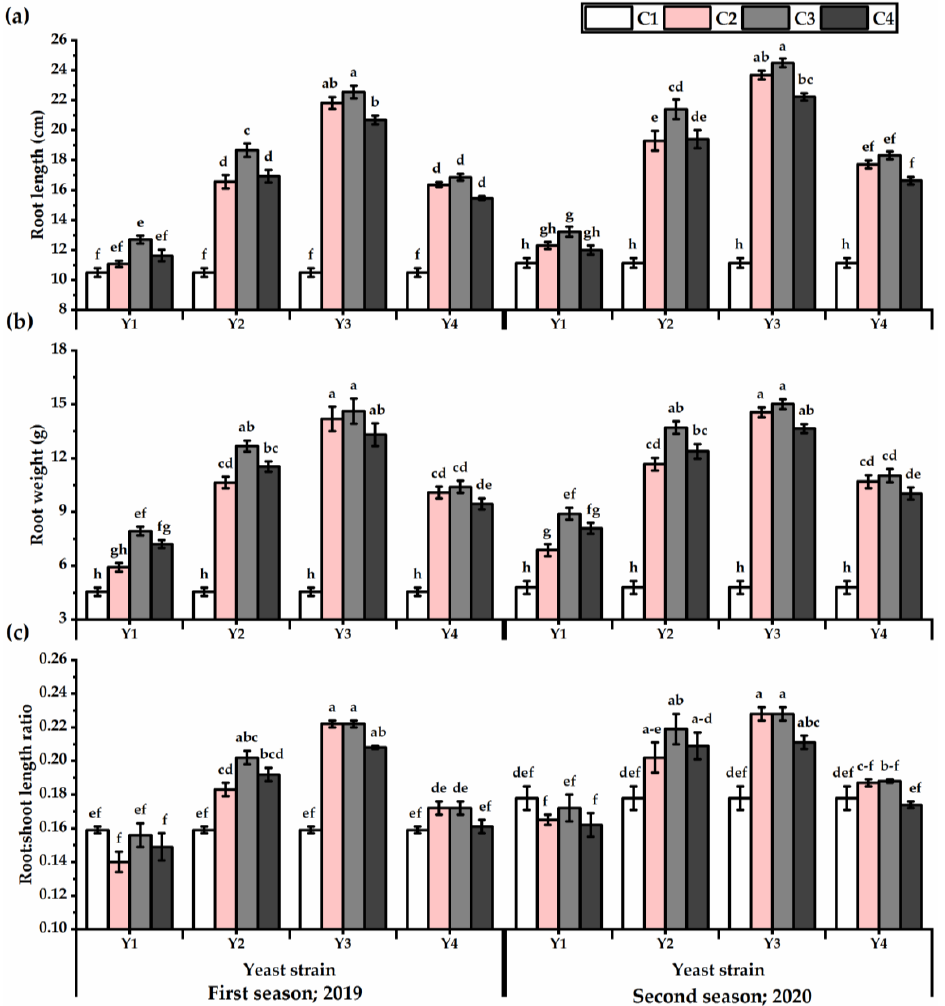
Figure 2. Root length (cm) ( a ), root weight (g) ( b ), and root:shoot length ratio ( c ) of Plectranthus amboinicus (Lour.) Spreng. plants subjected to Rhodotorula muciligenese (Y1), Candida sake (Y2), Candida apicola (Y3), and Candida kunwiensis (Y4) yeast strains foliar application at 0 (C1), 1 × 10 4 (C2), 1 × 10 7 (C3), and 1 × 10 9 (C4) CFU mL –1 concentrations during 2019 and 2020 seasons. Data are mean value ± SE. Means with different letters for each season significantly differed, using Tukey’s test at p ≤ 0.05 level, n =